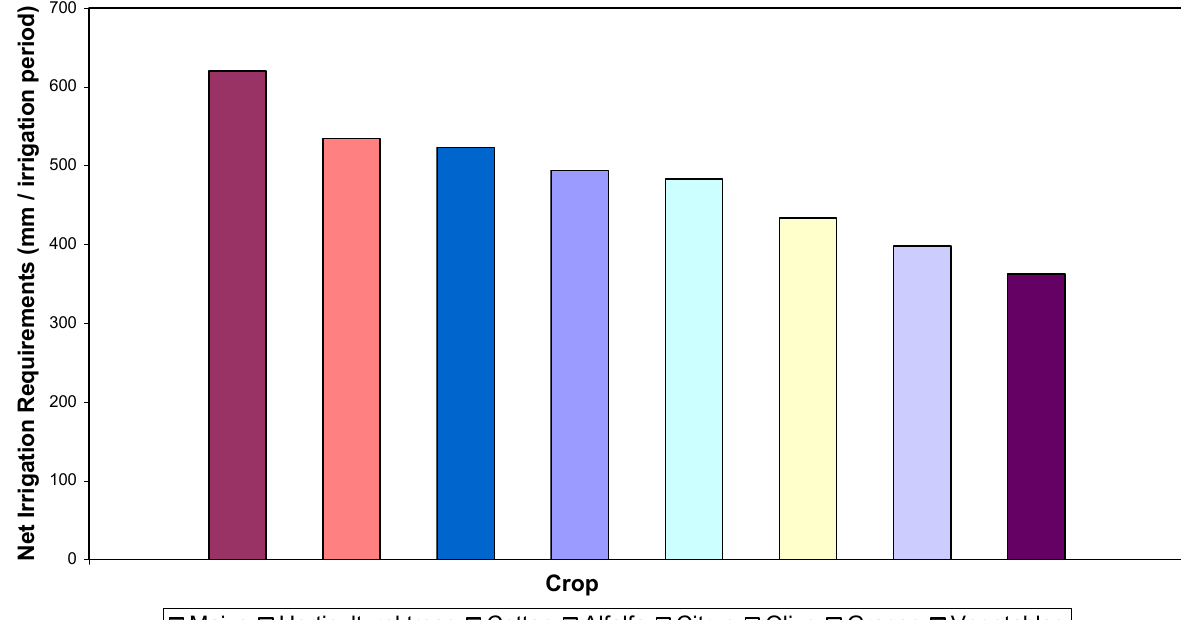
Figure 2. Net Irrigation Requirements for crops in Messologhion